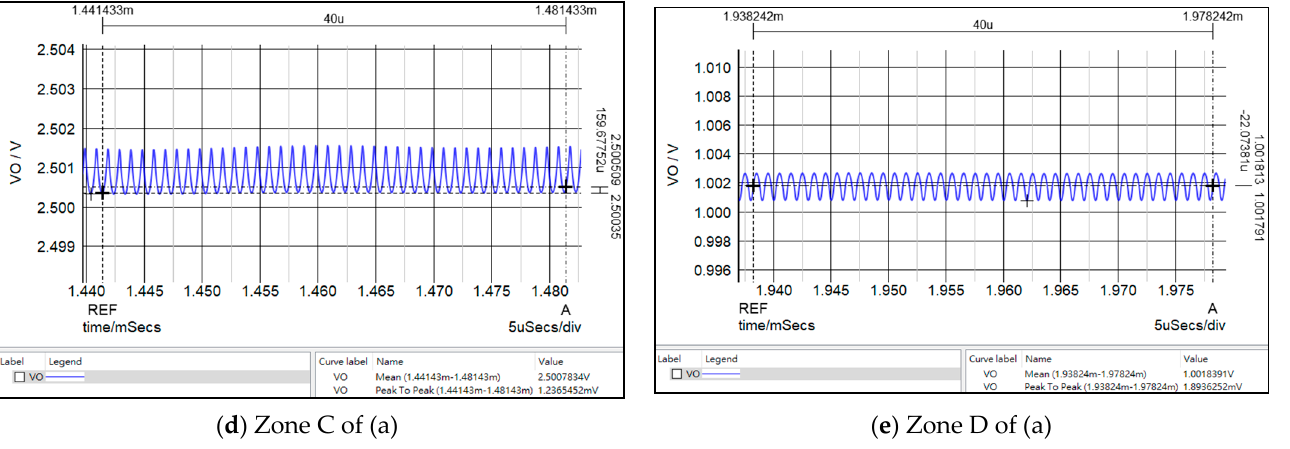
Figure 10. Performance of the converter for V in range of 3.0 – 3.6 V.